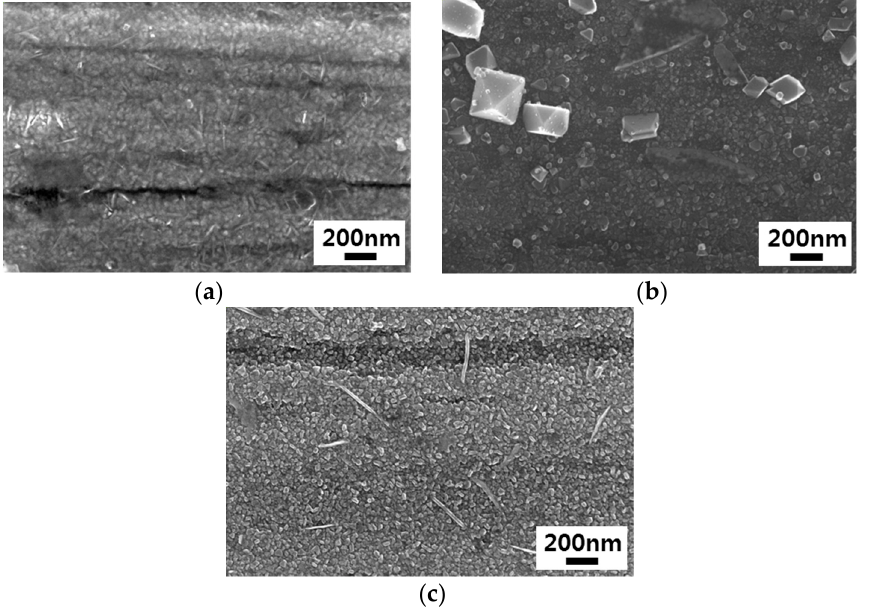
Figure 7. SEM image of surface oxides formed on the specimens tested for 100 h: ( a ) Tube; ( b ) Rod; ( c ) Plate.